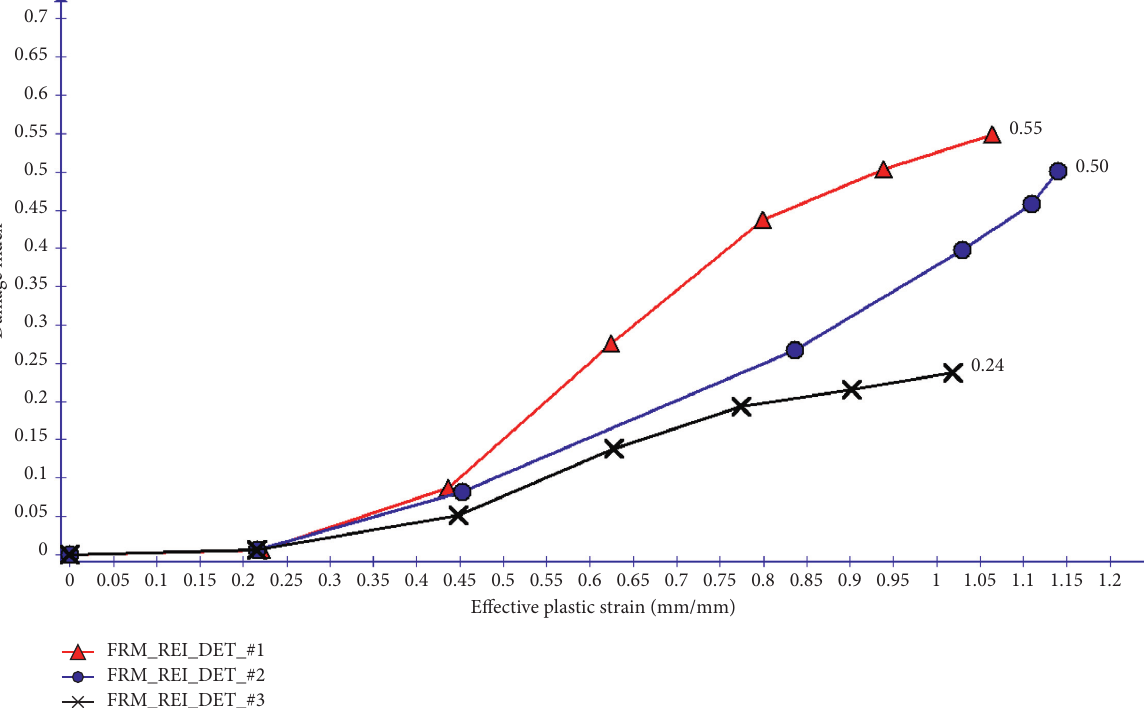
Figure 23: Column damage index vs. effective plastic strain plot for 215kg TNT explosive located at 1 st story ground floor slab.